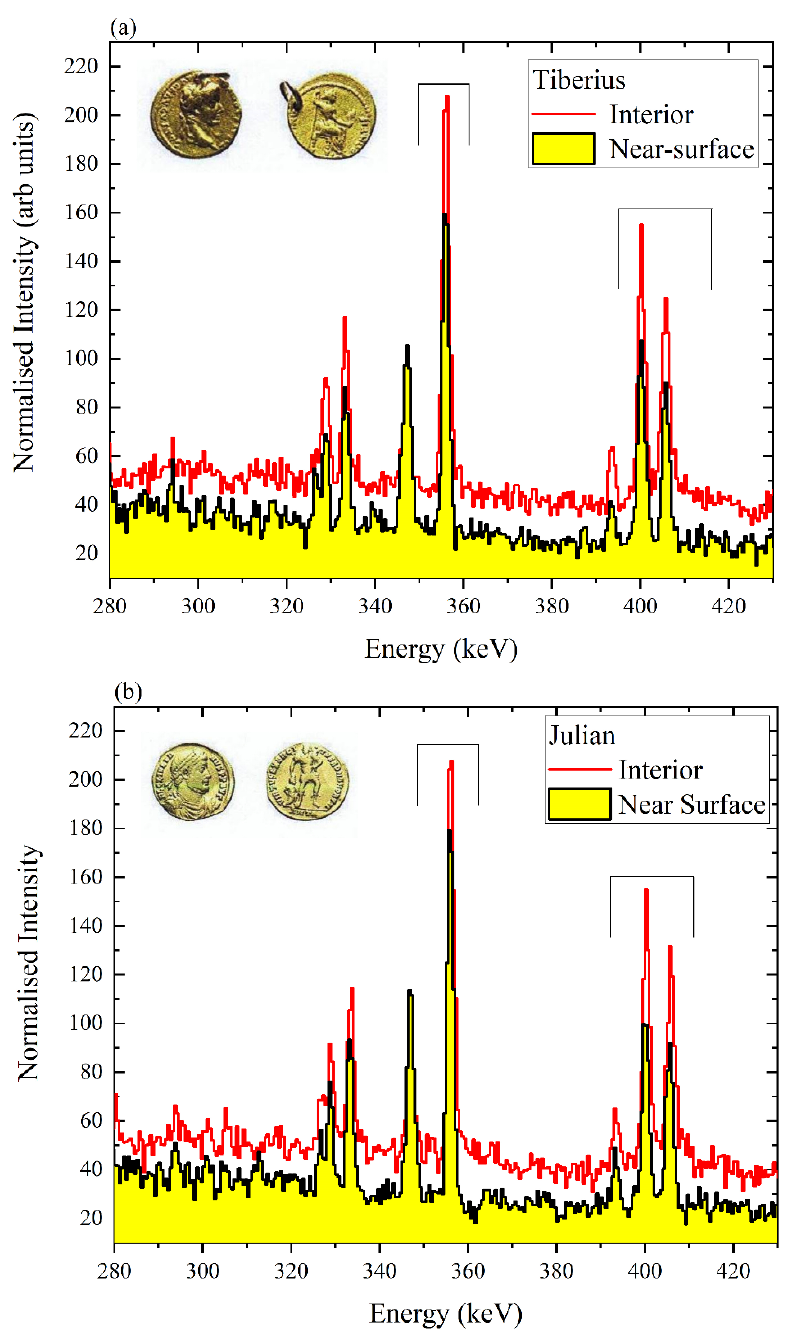
Figure 9. Spectra of Tiberius ( a ) and Julian ( b ) measured coins. Gold is present in both coins with a double peak at 400 keV and 406 keV and a gamma peak at 355 keV. As mentioned before, the surface (yellow) is representative of the interior (red). Reprinted with permission from Ref [37] © 2021, Elsevier Ltd. Table 2. Comparison of the XRF and Muon analysis. The results of the muon analysis are reported in the right columns. It is evident that the information coming from the surface (at 18 MeV/c) and the core (40 MeV/c) have no relevant difference: in this case, the surface is representative of the bulk composition. The data was taken from and adapted with permission from Ref. [37] © 2021, Elsevier Ltd.